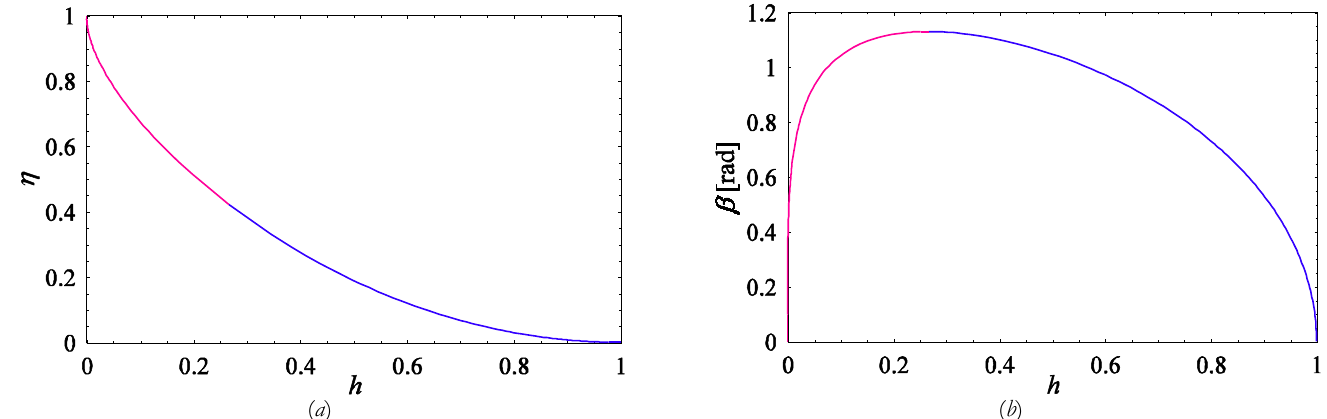
Figure 3: Analytical parametric plot as a function of non-dimensional horizontal thrust h (  ): (a) least thickness to radius ratio  (  ); (b) inner hinge angular position 